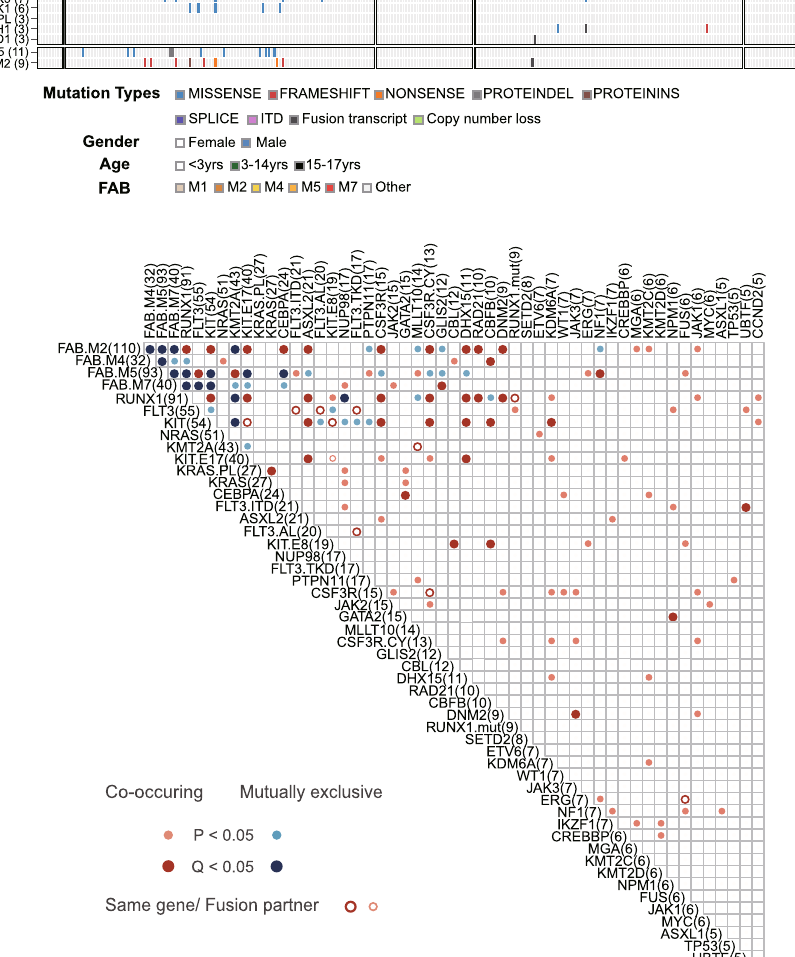
Fig. 3 Landscape and correlation of driver genes in Chinese AML. a Heat-map displays genes mutated in ≥ 3 AML cases. Cases are separated into FAB groups (columns), and the genes are grouped into six biological pathways (rows). Colors represent mutation types. b Pairwise co-occurrence (red) and mutual exclusive (blue) correlations between driver genes (two-sided Fisher ’ s exact test). The correlations are labeled with hollow circle if the pairs of mutations/genes were from a same gene or